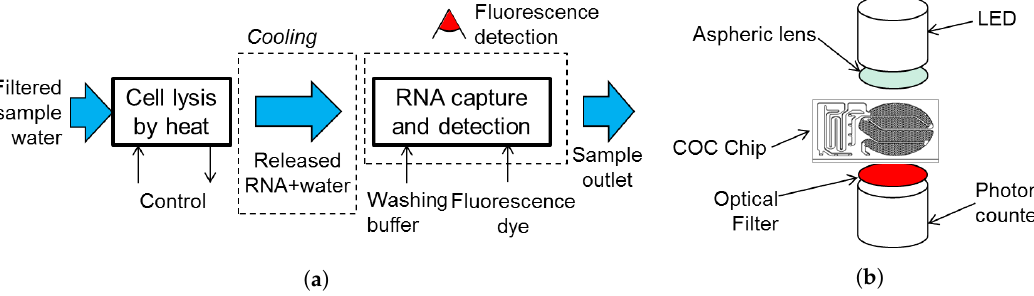
Figure 5. ( a ) Scheme of the experimental setup for testing the biosensor. ( b ) Scheme of the used fluorescence detection